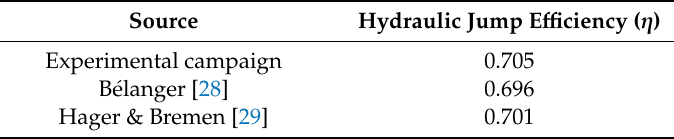
Table 4. Hydraulic jump e ffi ciencies obtained in the physical model and with bibliographic